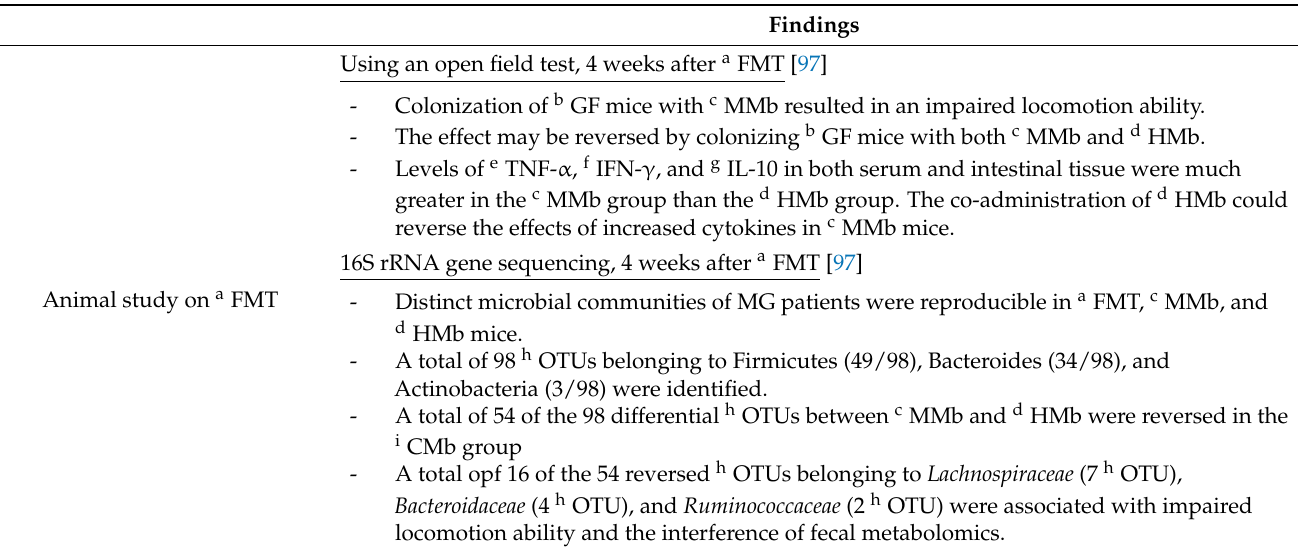
Table 2. Findings of fecal microbiota transplant (FMT) in relation to myasthenia gravis (MG) us- ing mice.